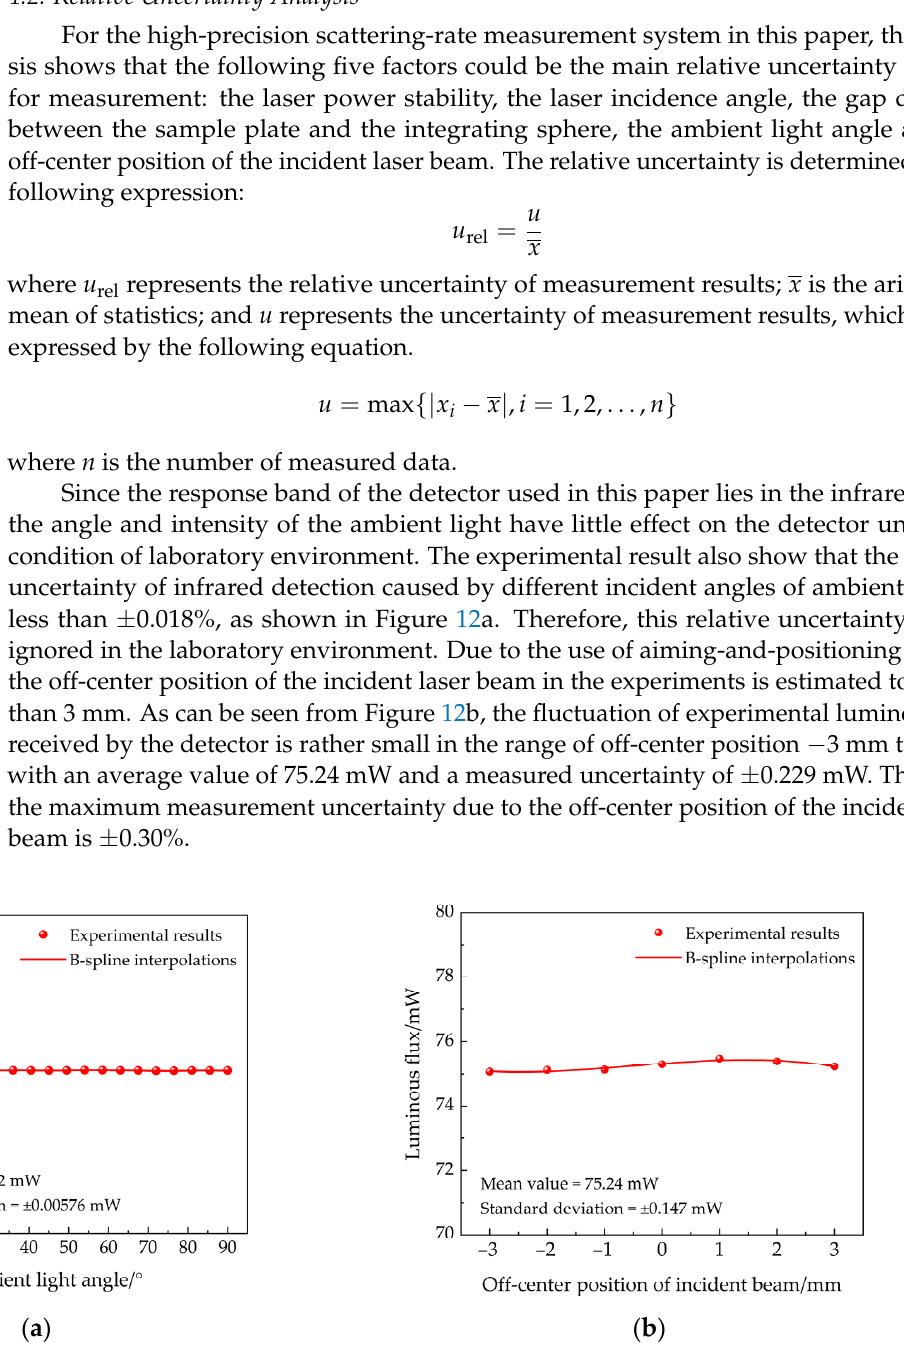
Figure 12. Influence of ambient light angle and off-center position of incident beam on experimental luminous fluxes: ( a ) ambient light angle and ( b ) off-center position of incident beam.